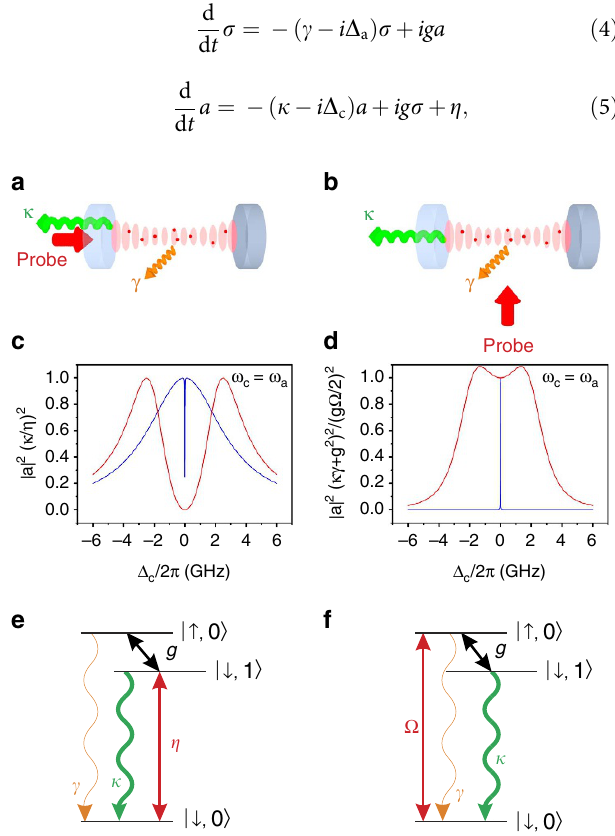
Figure 2 | Schemes for probing the dressed atom–cavity system. ( a ) Experimental configuration for driving the cavity mode. The field is probed through the cavity reflection. ( b ) Experimental configuration for driving the atoms. The field inside the cavity is probed by measuring light emitted through one of the cavity mirrors. ( c ) Number of intracavity photons, | a | 2 , versus detuning for configuration ( a ). The narrow dip (blue) is for C ¼ 1 (that is, g /(2 p ) ¼ 95MHz, k /(2 p ) ¼ 3GHz, g /(2 p ) ¼ 3MHz), while the wide one (red) is for strong coupling— g /(2 p ) ¼ 2.5GHz—which lies in zone (iii) of Fig. 1b. We scale the photon number by ( k / Z ) 2 (a very large number in our case) to obtain a curve that is independent of the probe strength Z . ( d ) Intracavity photon number (suitably scaled again) as a function of detuning for configuration ( b ). The narrow peak (blue) is for C B 1. The wide peak (red, g /(2 p ) ¼ 2.5GHz) is only just beginning to exhibit a dip at strong coupling. ( e , f ) Effective three-level systems corresponding to configurations a and b , respectively. The cavity is assumed to be red-detuned from atomic resonance ( o c o o a ), leading to a ladder system in e and a L system in f ; for blue detuning the configurations are reversed. For either detuning, the system supports a DITcoherence window in e and does not in f